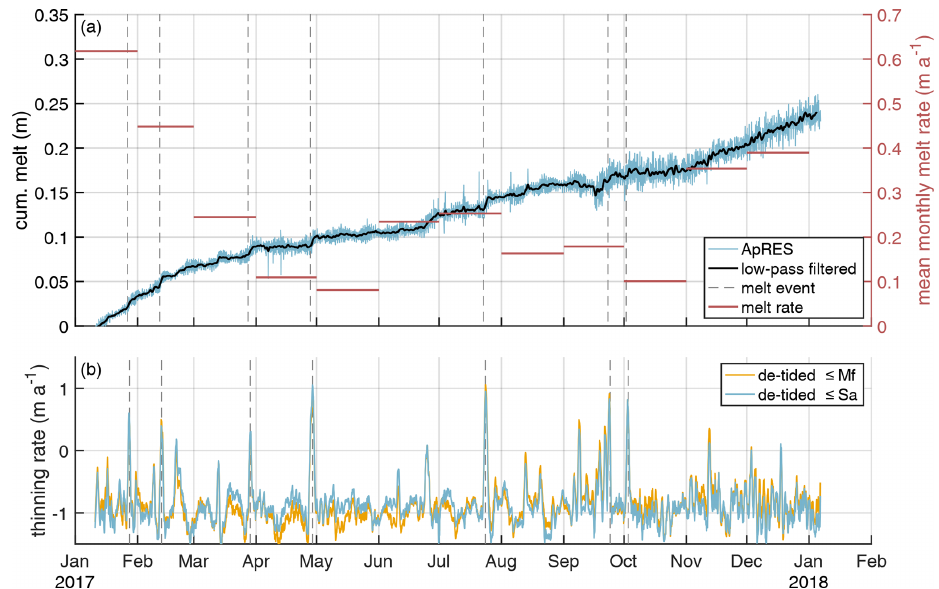
Figure 4. Time series of basal melting at the ApRES location outside the channel. (a) Cumulative melt (blue line, left y axis) over the measurement period from 10 January 2017 to 6 January 2018 with low-pass-filtered time series (black line). In September 2017, a malfunction of the ApRES caused a change in the attenuation which resulted in a noisier time series. Monthly mean melt rates are shown by red lines on the right y axis. Due to the inaccuracy in the determination of the strain, the cumulative melt still contains a contribution from strain. (b) Thinning rate after subtracting of the tidal signal up to the fortnightly constituent (yellow line) and up to the solar annual constituent (blue line). The dashed gray lines in panels (a) and (b) mark stronger melt events.